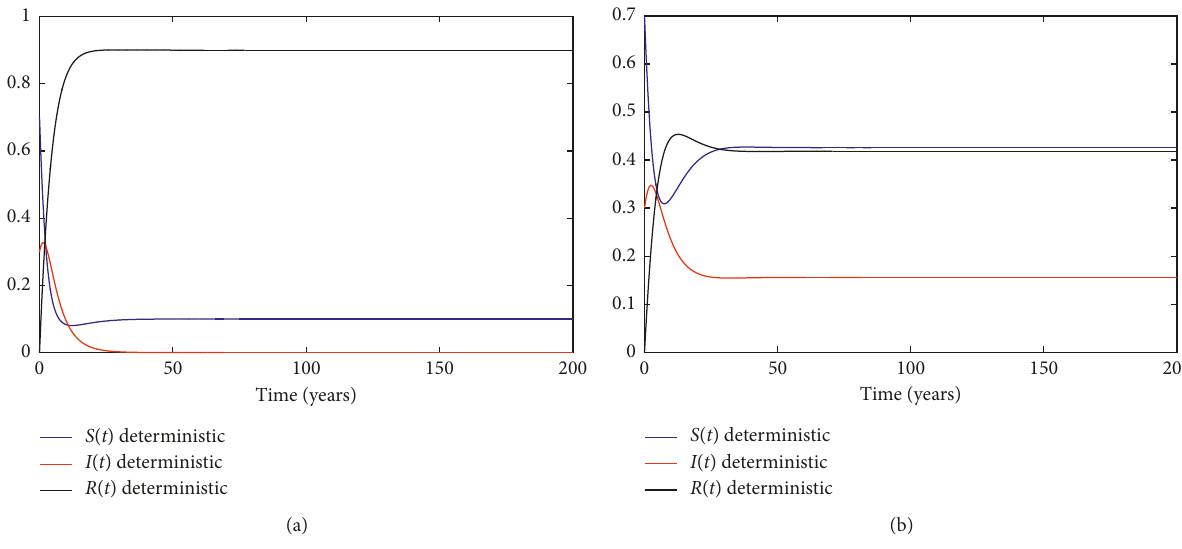
Figure 1: Simulations of the path S ( t ), I ( t ), and R ( t ) for the corresponding deterministic system (1).